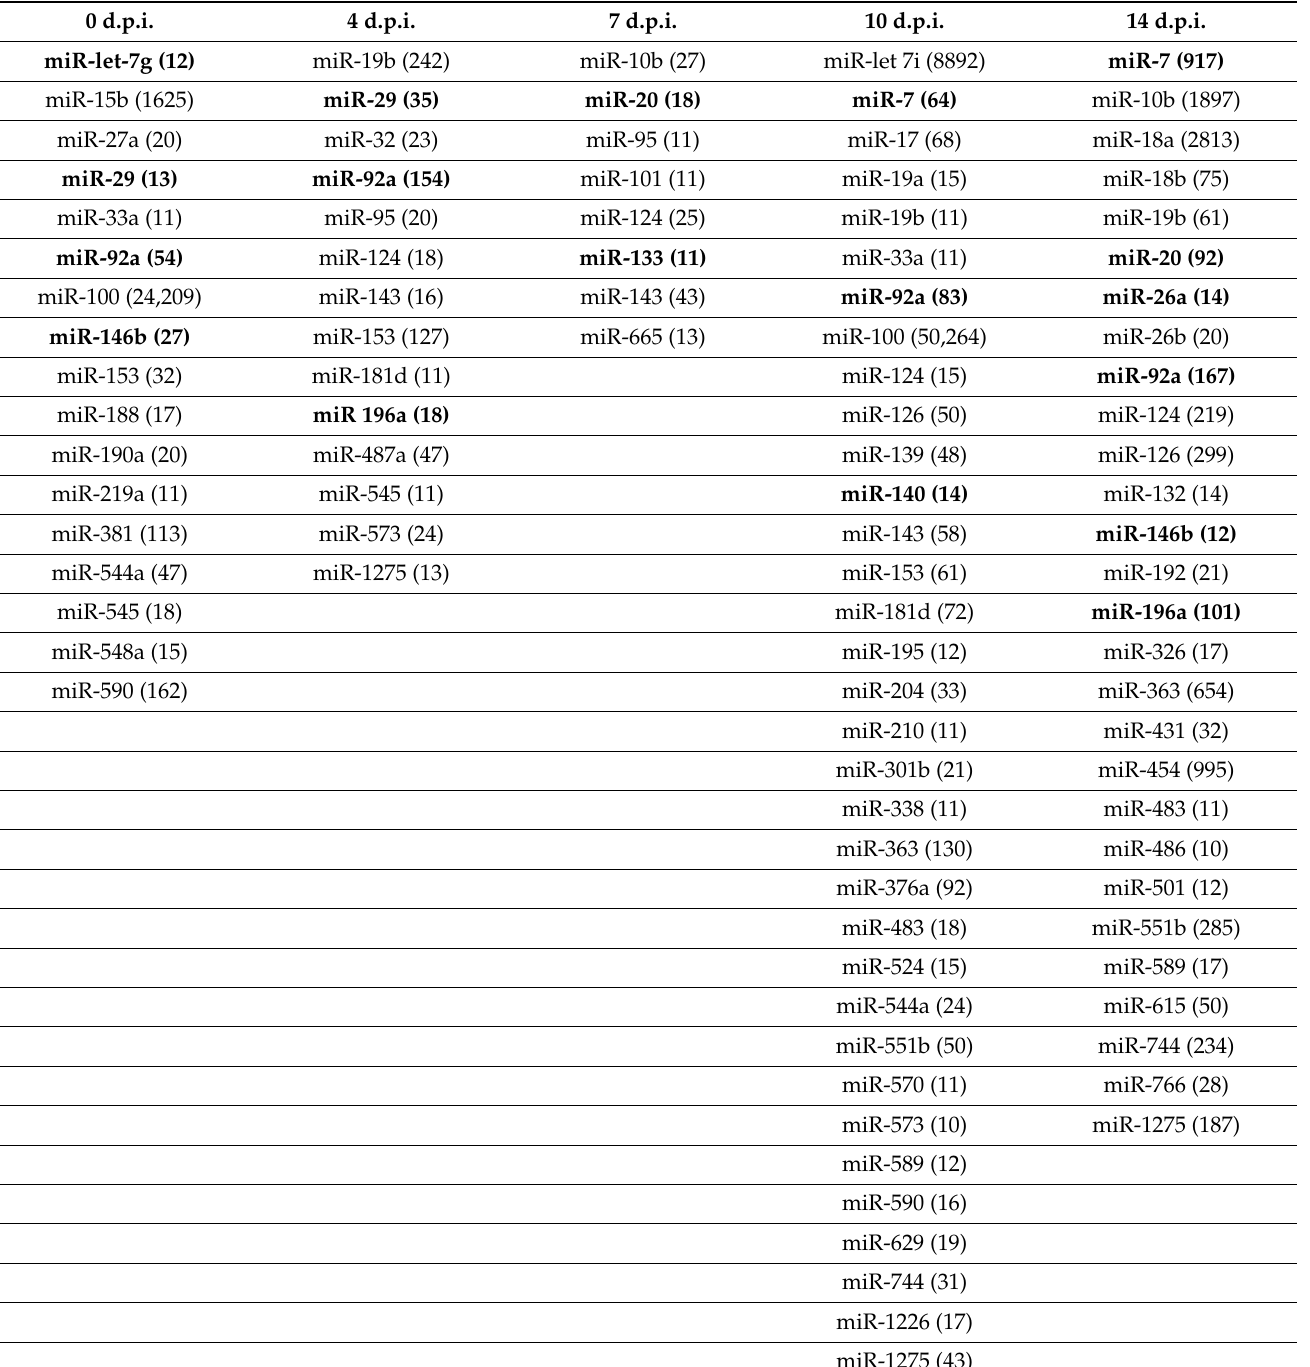
Table 2. Most up-regulated (>10-fold) miRNAs in human cytomegalovirus (HCMV) infected fibroblasts at 0, 4, 7, 10 and 14 days post-infection (d.p.i.)